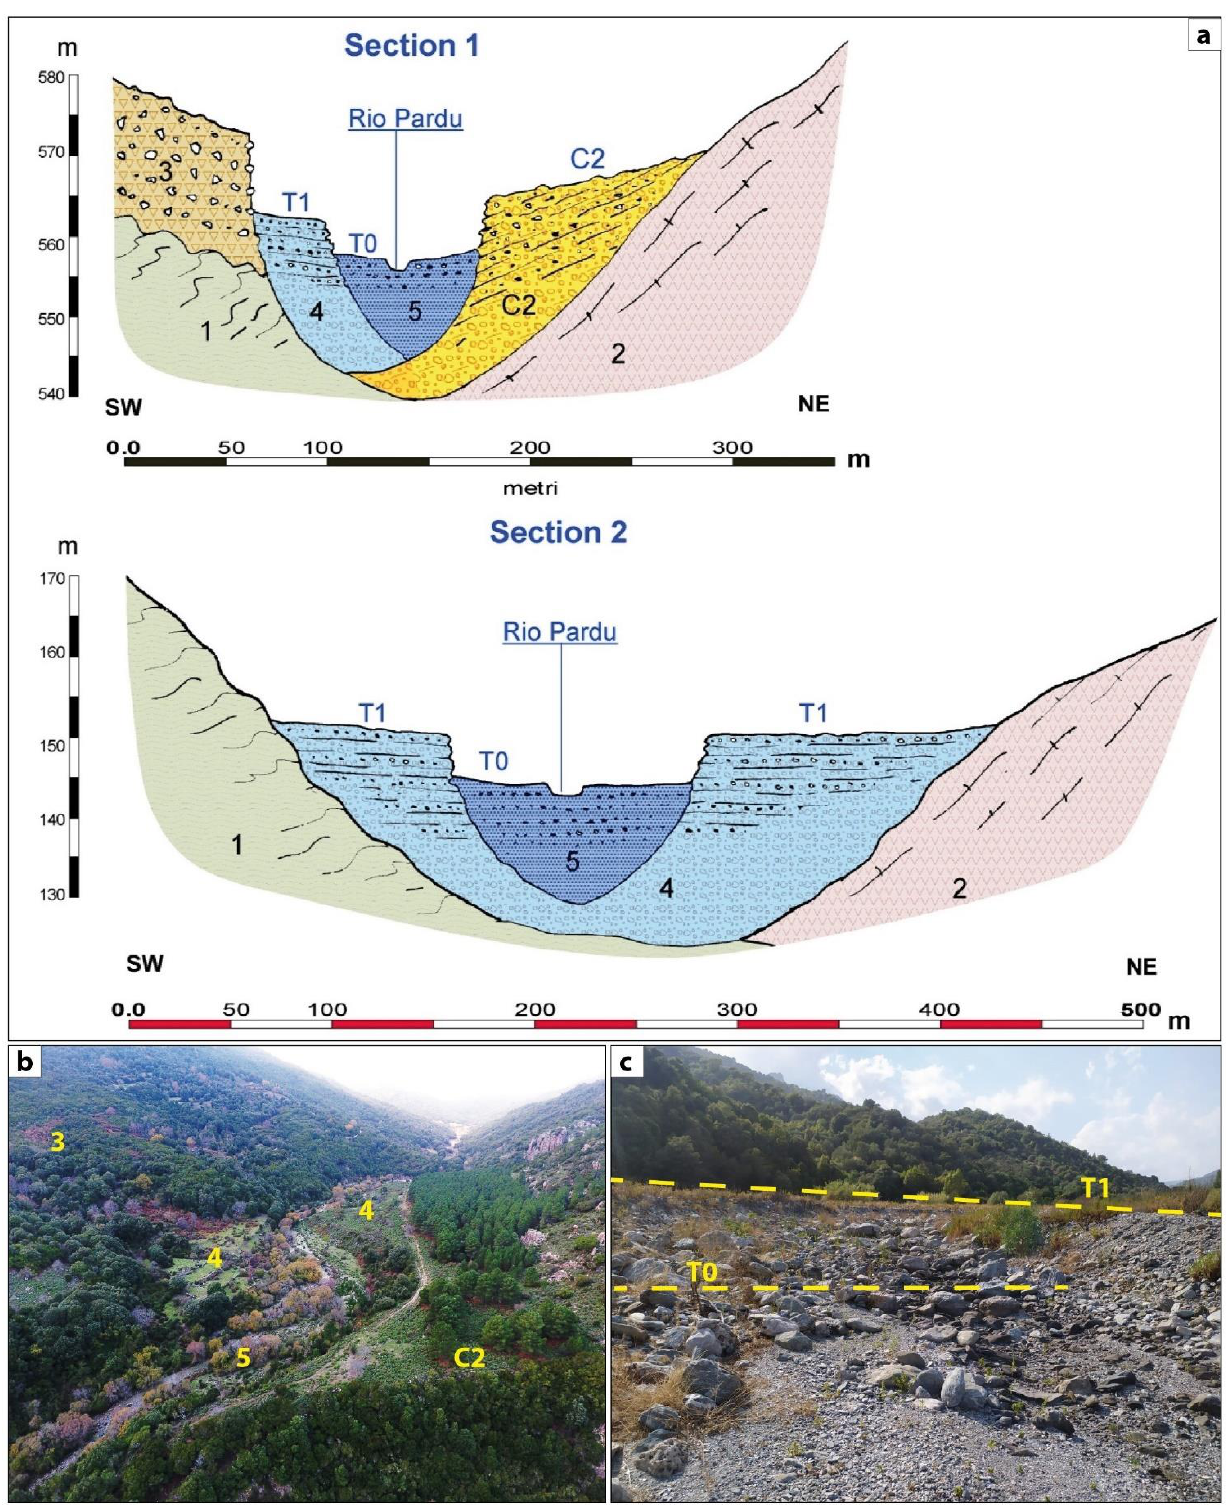
Figure 12. ( a ) Morphostratigraphic profiles of the Pardu River. ( b ) UAV photo near the head of the Pardu River. ( c ) The bottom of the Pardu Valley near the capture elbow. Lithological legend: (1) Filladi Grigie del Gennargentu Formation; (2) Monte Santa Vittoria Formation; (3) paleo-rockfall deposits; (C2) paleo-conoid; (4) Terrace T1; (5) Terrace T0.